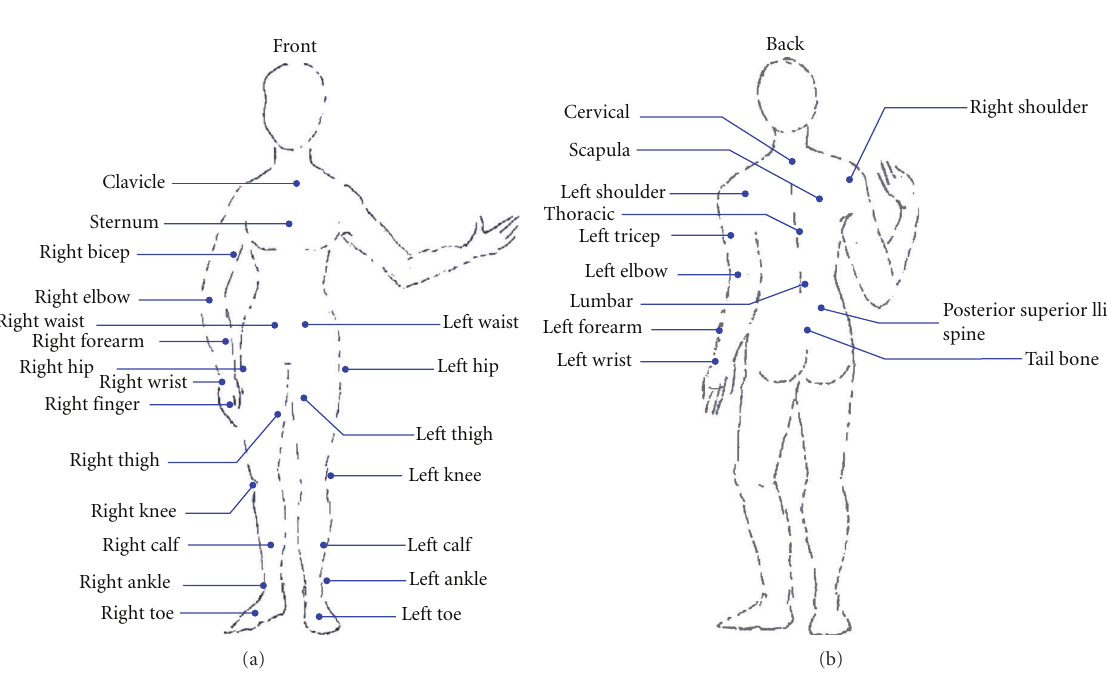
Figure 4: Marker set schematic showing front and back sides of the